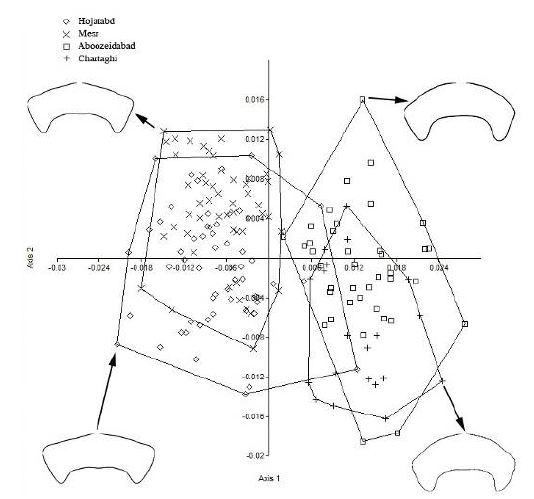
F IGURE 6.- Canonical variate analysis scatter plot of four samples of Erodiontes spp. Species are shown with different